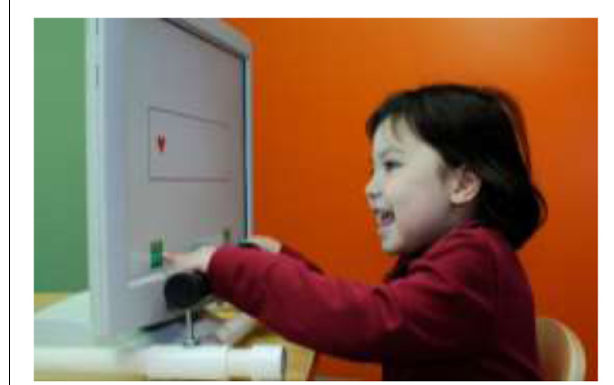
FIGURE 2 |A child performing the hearts and flowers test using a touchscreen monitor and handlebars.